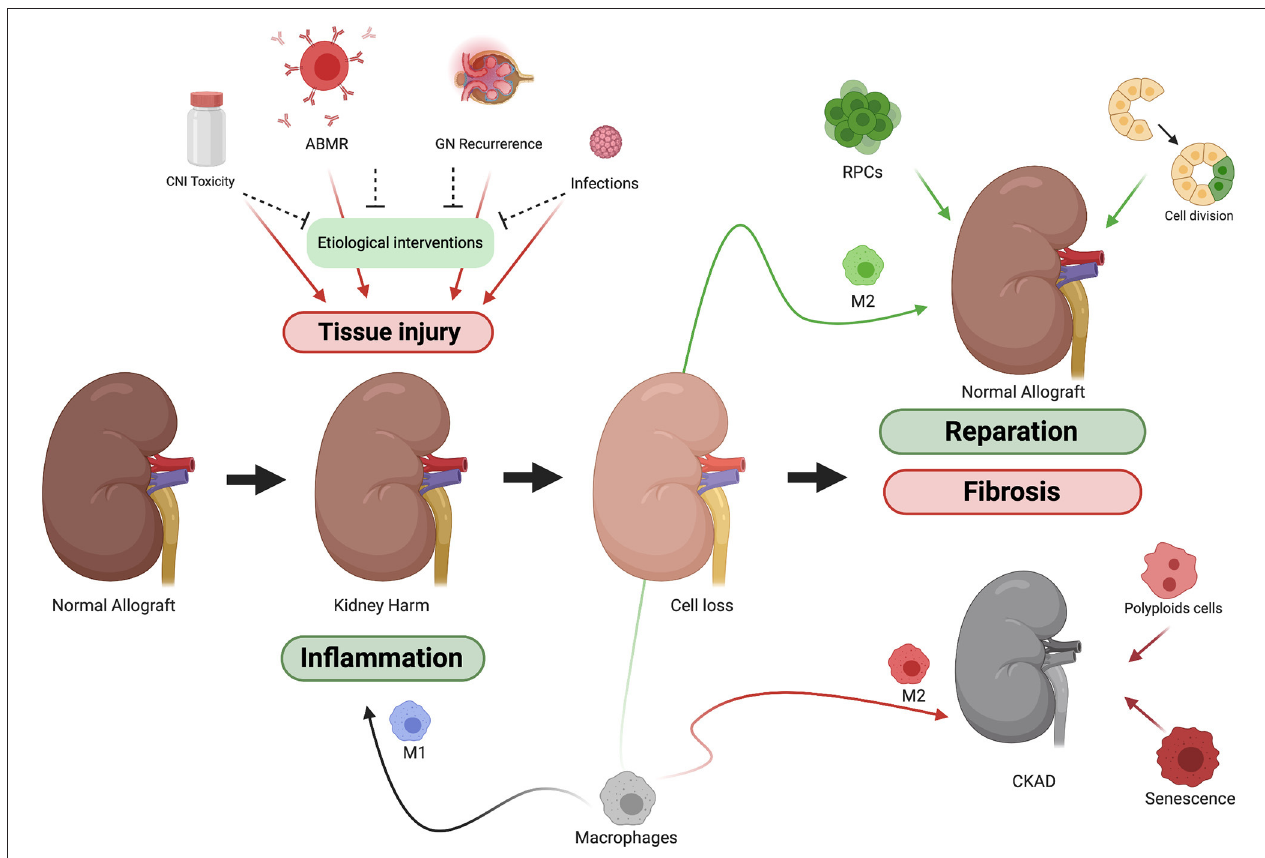
FIGURE 1 | Schematic representation of kidney allograft injury and reparation process. Kidney allograft is exposed to many insults. Although there are mechanisms to protect the graft from each of them, tissue damage is often present at the end. Once the tissue is injured the kidney’s owns mechanisms of reparation come into action. To stop the insult, M1 macrophages among others will trigger and inflammatory response. After that, the damage caused (cell loss) must be compensated. Factors like the type and duration of the damage or the age of the donor will determine whether the reparation process tends more toward reparation or scarring